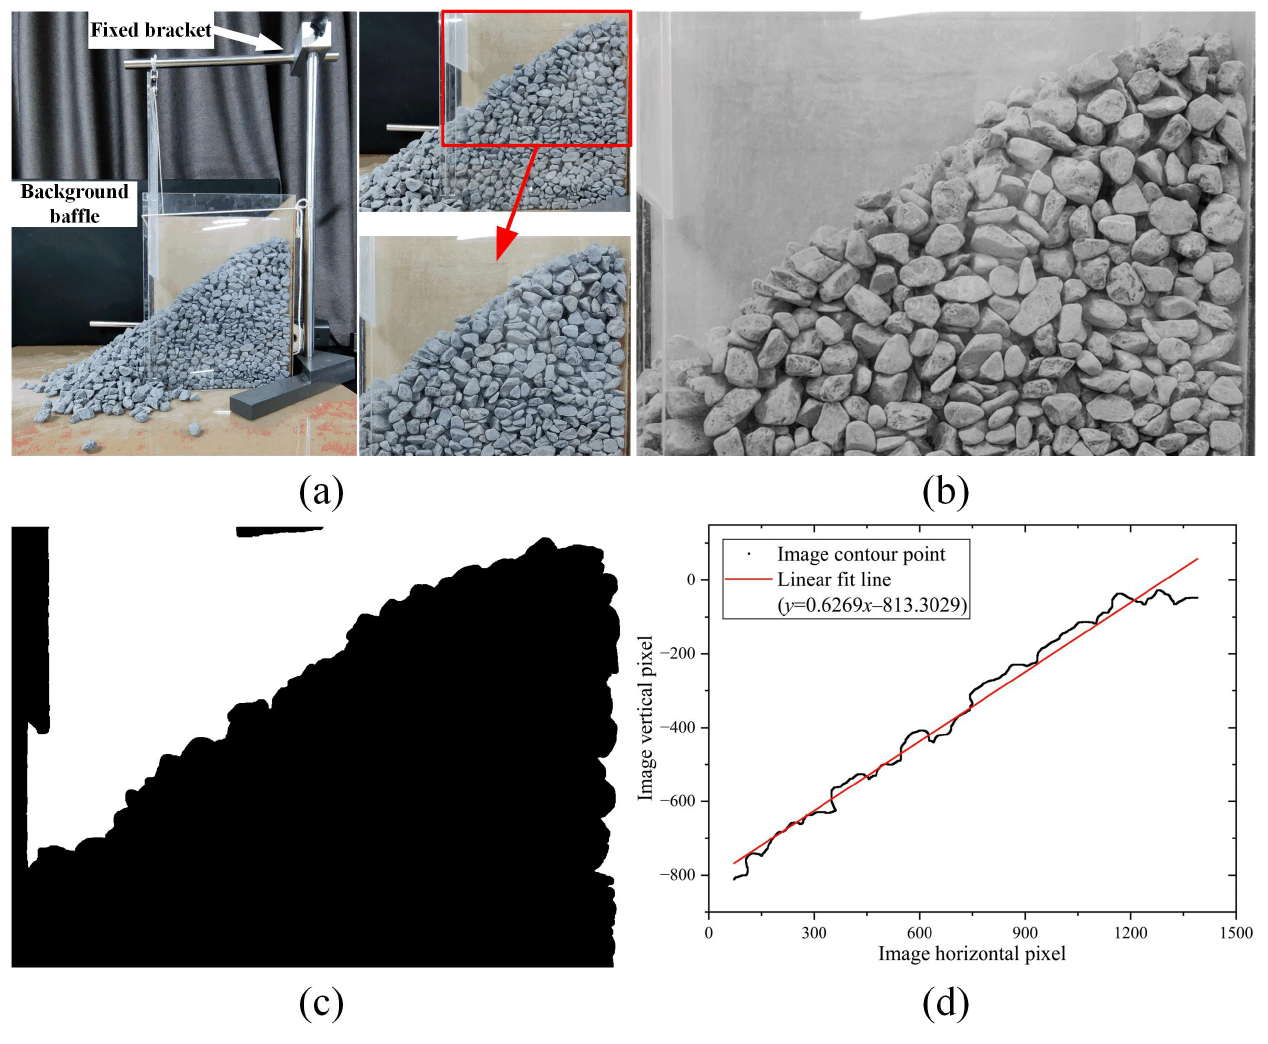
Figure 3. Measurement process of static angle of repose: ( a ) original image; ( b ) grayscale image; ( c ) binarized image; ( d ) linear fitting image.